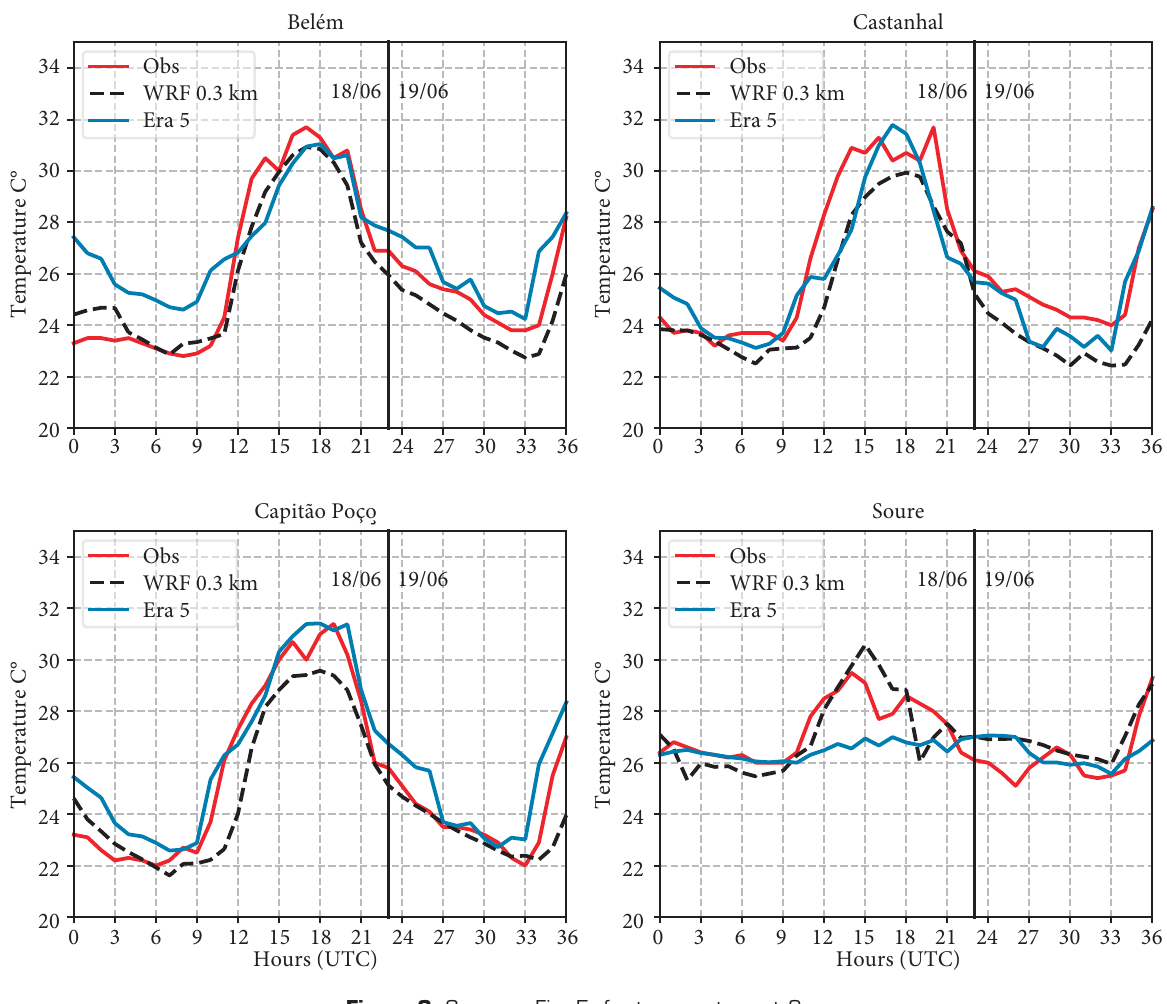
Figure 6. Same as Fig. 5, for temperature at 2 m. Table 2. Error statistics for each locality in June 18 th ,